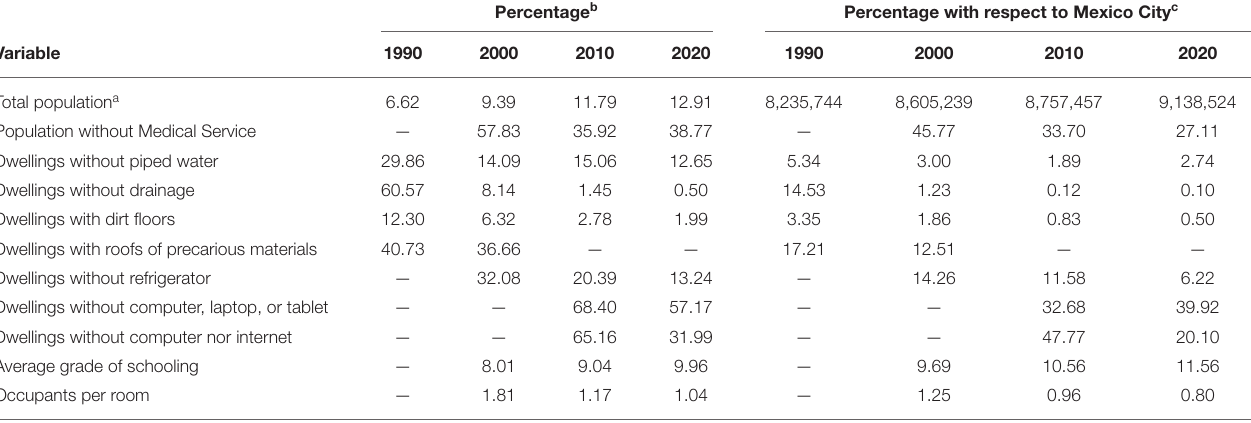
TABLE 2 | The conservation zone: socioeconomic indicators, 1990–2020.